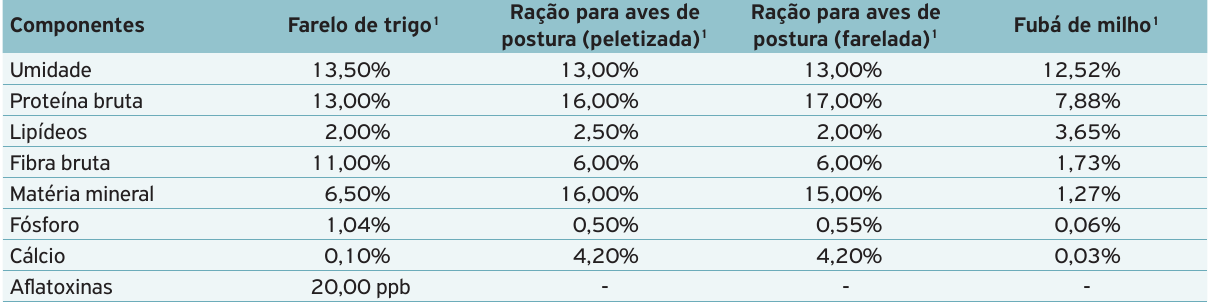
Tabela 1. Composição nutricional das dietas fornecidas a Tenebrio